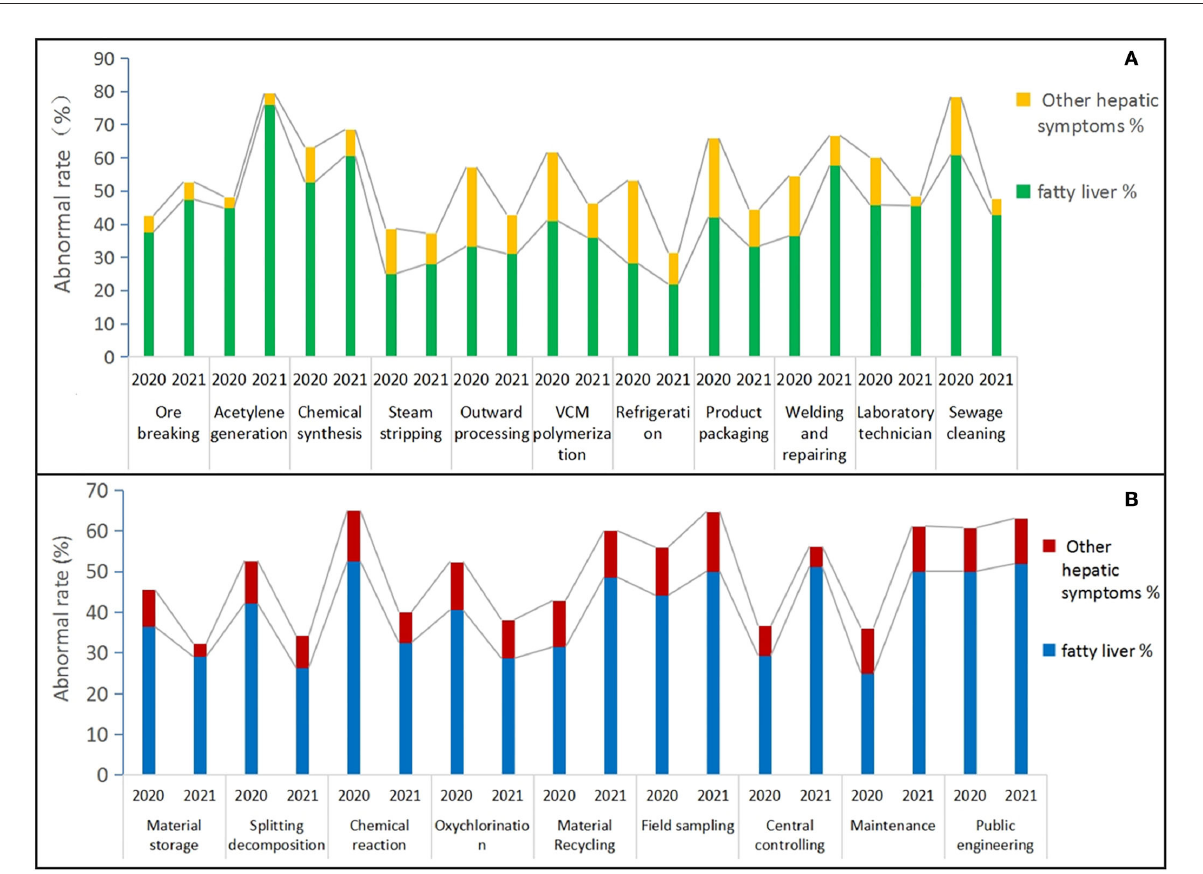
FIGURE3 Abnormal rates of alteration toward fatty liver and the other hepatic symptoms among all positions throughout Y and Z between 2020 and 2021 were visualized in histograms (A,B) . That chart (A) described the distribution of abnormal rates of fatty liver (green) and the other hepatic symptoms (yellow) for 11 positions in Y; Chart (B) presented the distribution of abnormal rates of fatty liver (blue) and the other hepatic symptoms (red) for nine positions in Z. Abnormal rates (%) for each position were, respectively, calculated through dividing the abnormal person-time of fatty liver or other hepatic symptoms to the total number of each relevant